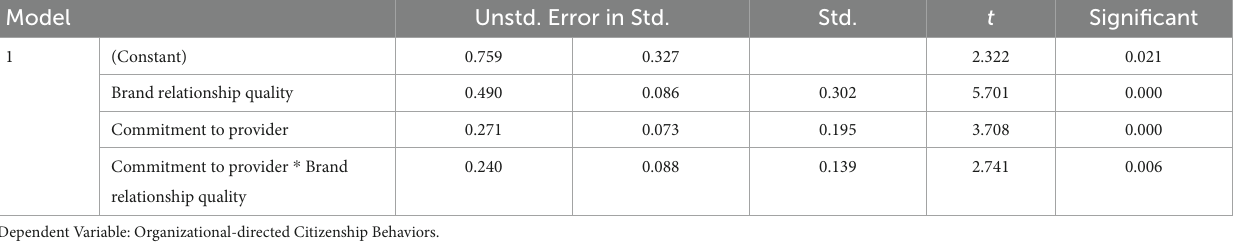
TABLE 10 Coefficient a analysis. Model